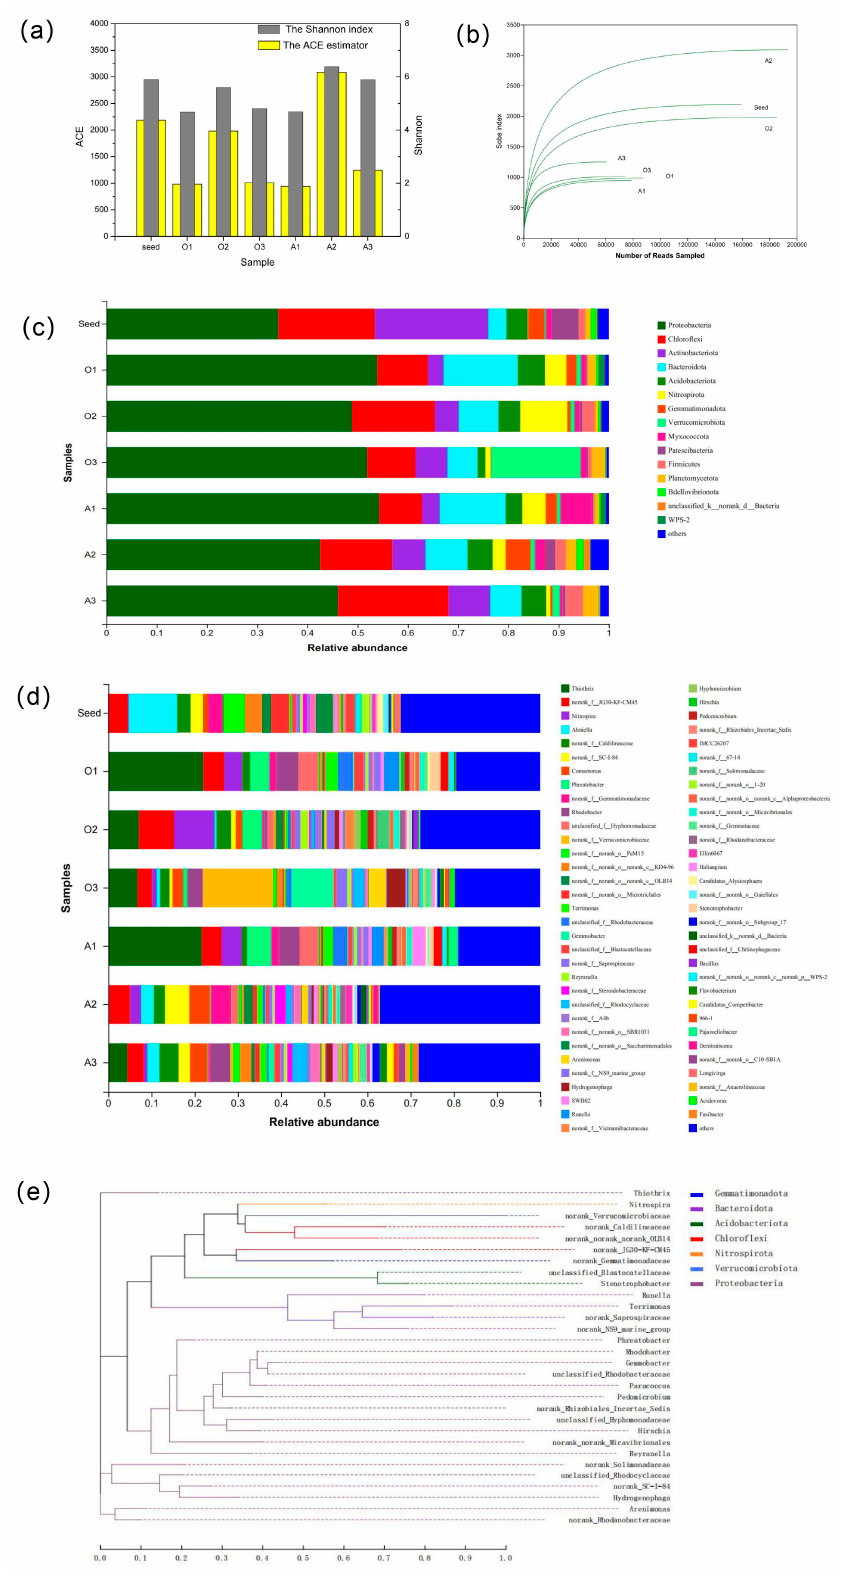
Figure 5. The bacterial diversity and bacterial population structure of the samples: ( a ) the ACE estimator and the Shannon diversity index; ( b ) rarefaction curves; ( c ) bar profiling graphs of samples at the phylum level; ( d ) bar profiling graphs of samples at the genus level; and ( e ) phylogenetic tree at the genus